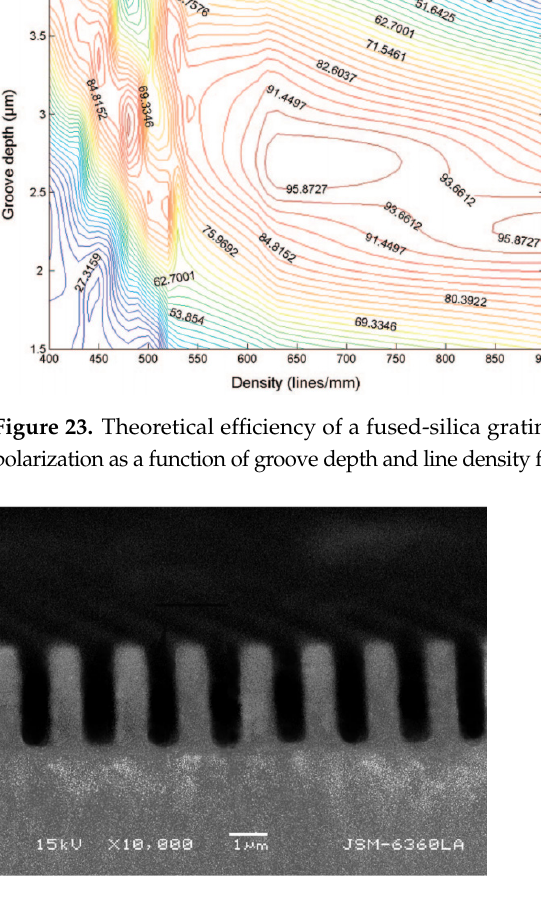
Figure 24. Fabricated fused ‐ silica grating with a density of 674 lines/mm, a groove depth of 2.5 μ m, and a duty cycle of 0.5.